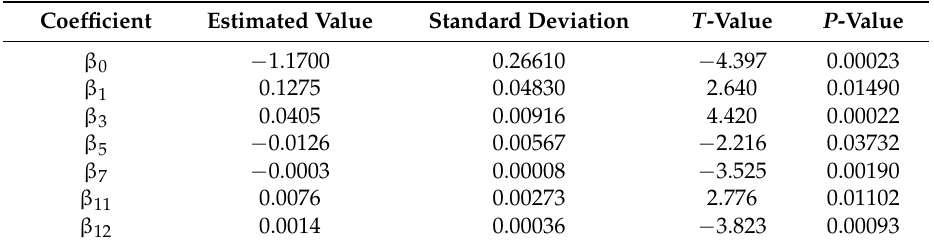
Table 6. Statistical parameters for the model coefficients according to the Box-Behnken design. Coefficient Estimated